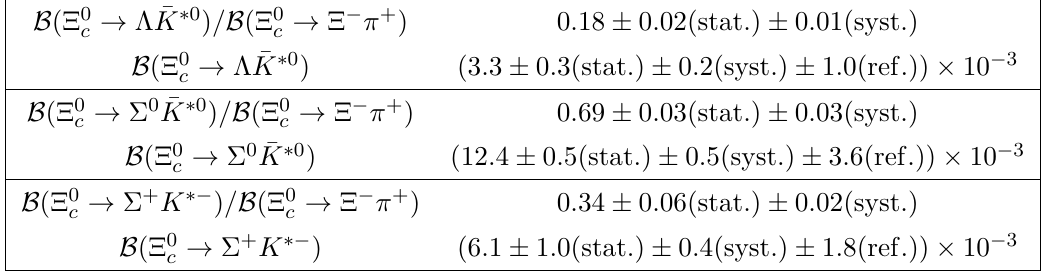
Table 3 . The branching fractions and ratios, where the uncertainties are statistical, systematic, and from B (Ξ 0 → Ξ − π + ) c